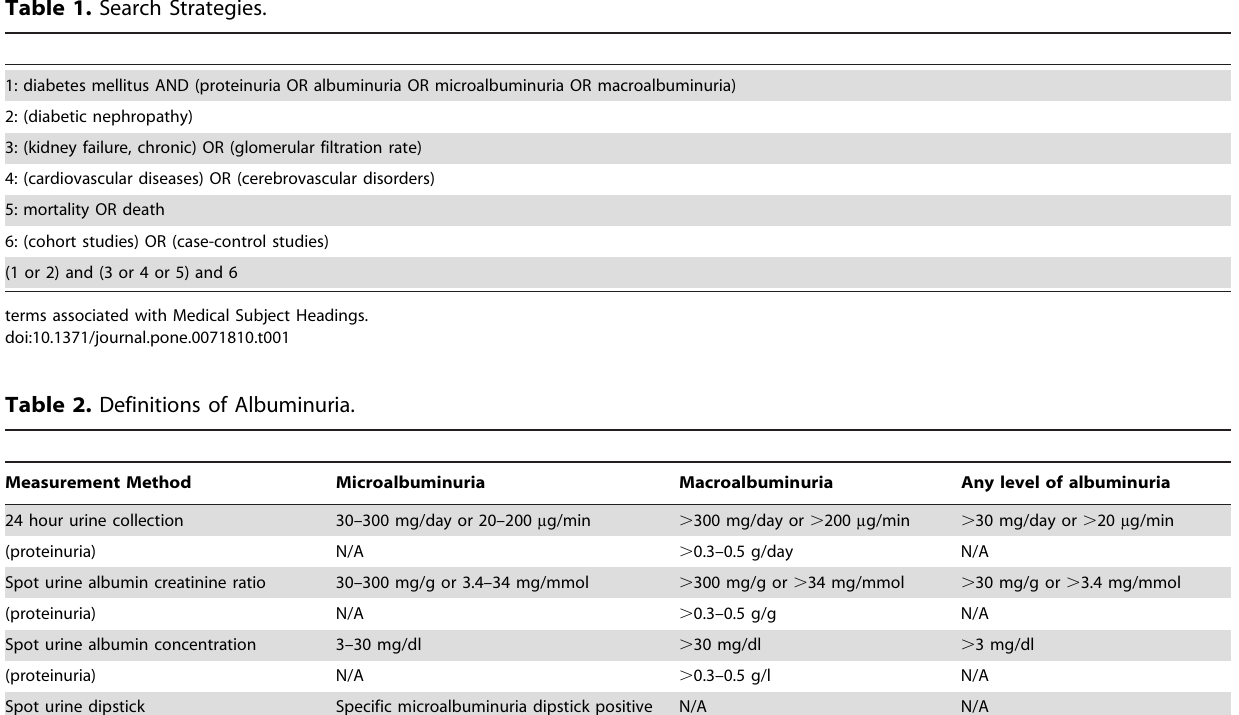
Table 1. Search Strategies.